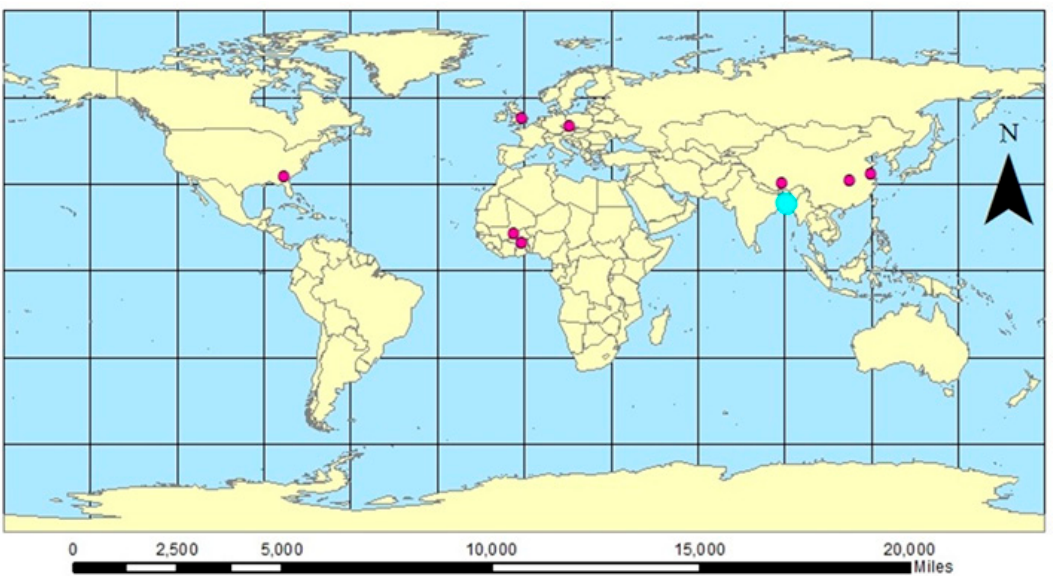
Figure 2. Rural locations covered in this study. * Blue dot represents all 3 studies conducted in Bangladesh (i.e., same location).